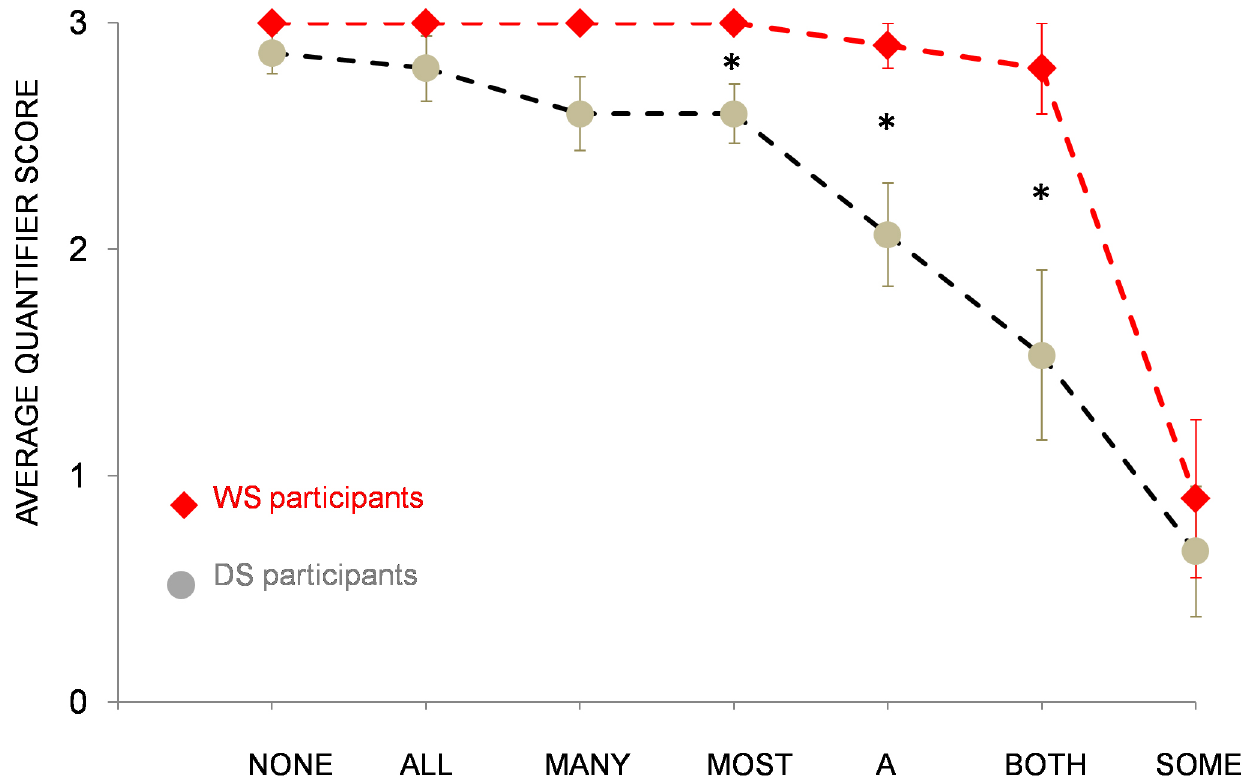
Fig 1. Comparison WS-DS. Average scores of participants with WS and DS for individual quantifiers. Error bars represent standard errors of the mean.